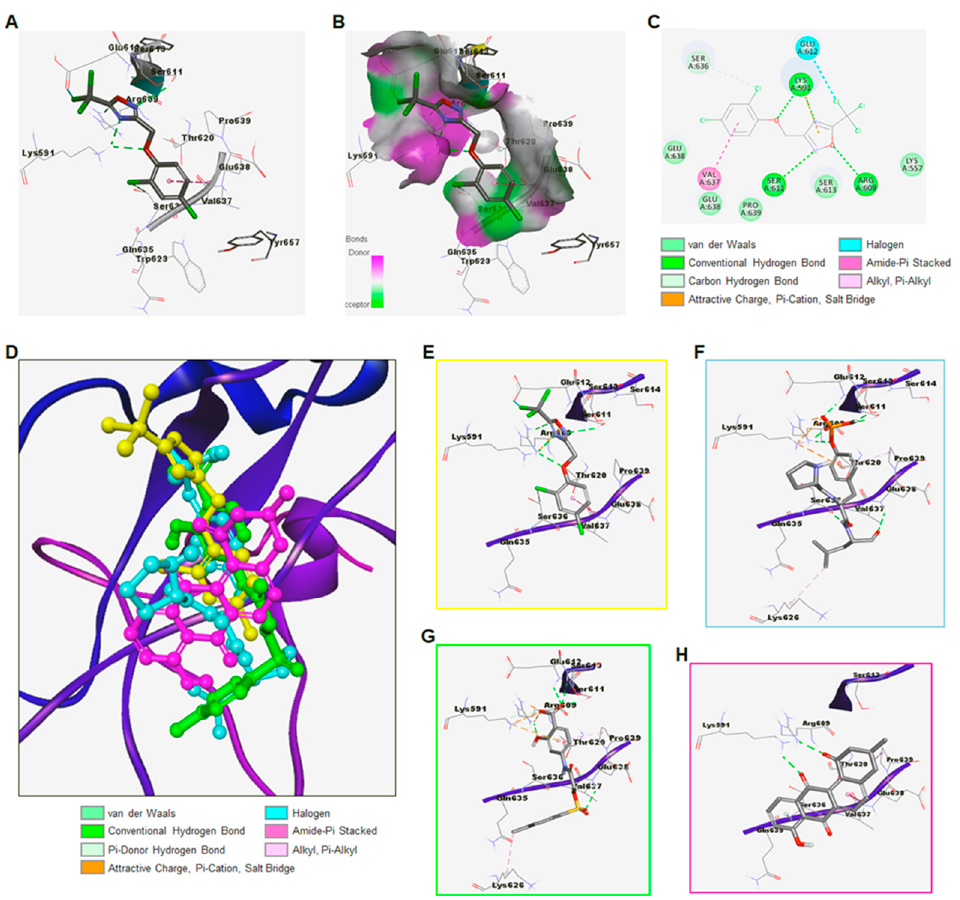
Figure 1. Molecular docking of ODZ10117 against the SH2 domain of STAT3. ( A ) Docked model of ODZ10117 is shown in stick and the surrounding residues of the SH2 domain of STAT3 are shown by a line model. Hydrogen bonds are shown for Lys591, Arg609, and Ser611. Halogen bond between Cl and Glu612 is shown by a cyan dash. ( B ) Transparent hydrogen bond acceptor/donor surface is shown for surrounding residues. ( C ) 2D-interaction plot is shown and color-coded by various interaction types. ( D ) Superimposed docked models of ODZ10117 (yellow), Pro-pTyr-Leu (cyan), S3I-201 (green), and STA-21 (magenta) over STAT3. (E-H) Docked models of ODZ10117 ( E ), Pro-pTyr-Leu ( F ), S3I-201 ( G ), and STA-21 ( H ) surrounding 4Å residues of STAT3. Color codes for the different types of interactions are shown at the bottom of D.